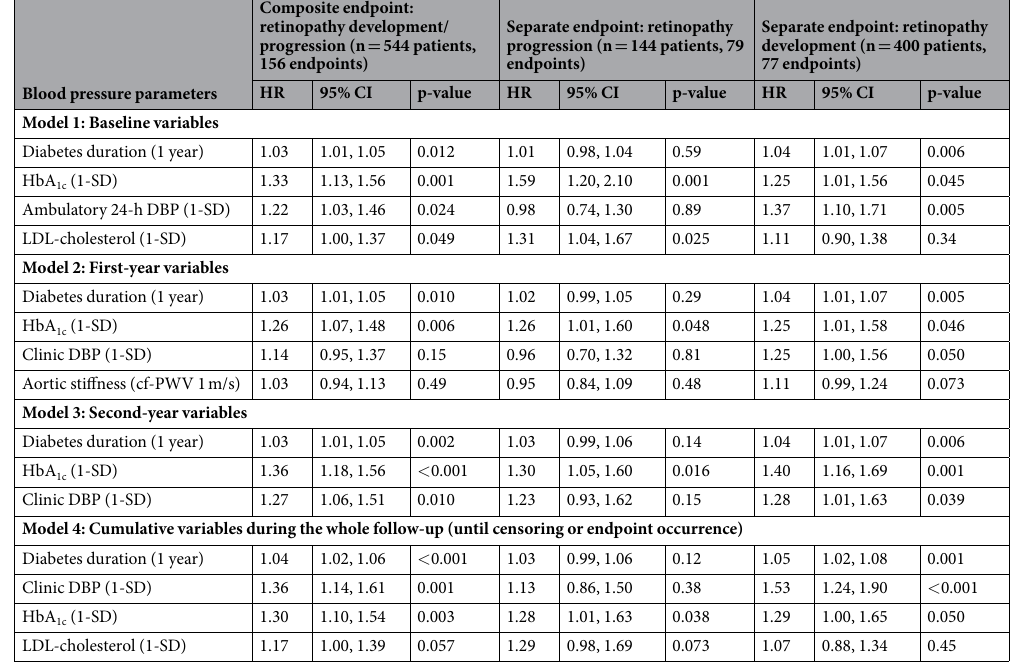
Table 2. Results of multivariate Cox regression analysis for the independent predictors of the composite and separate endpoints (development and/or progression of diabetic retinopathy) measured at different time- intervals during follow-up. Candidate variables to enter the models were the following: age, sex, BMI, smoking status, physical activity, presence of any macro- and microvascular complications, diabetes duration and classes and numbers of anti-diabetic and anti-hypertensive medications (in all models); ambulatory 24-hour systolic and diastolic blood pressures (in the baseline model); aortic stiffness (in the first-year model); and baseline, mean first-year, second-year and cumulative HbA1 c , LDL- and HDL-cholesterol, and clinic systolic and diastolic blood pressures (in their respective models). Regardless of their significance, all models were further adjusted for age, sex and presence of diabetic retinopathy, nephropathy and peripheral neuropathy at baseline. Abbreviations: HR, hazard ratio; CI, confidence interval; HbA 1c , glycated hemoglobin; SD, standard deviation; DBP, diastolic blood pressure; LDL, low-density